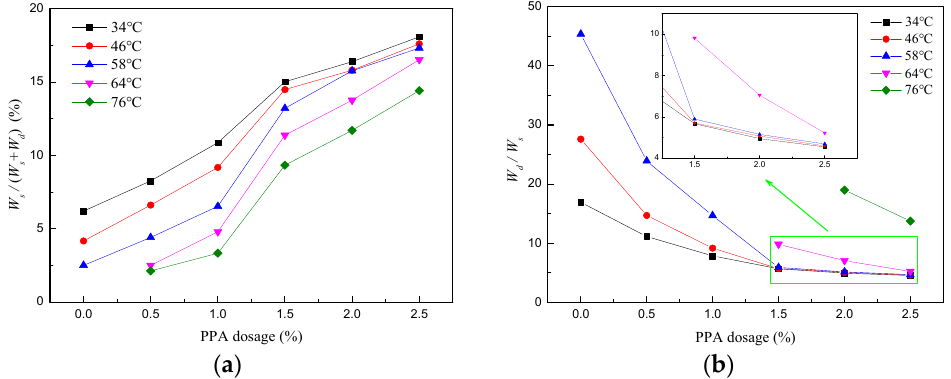
Figure 14. Energy ratio under different test conditions: ( a ) Percentage of stored energy at 0.1 kPa; ( b ) dissipation energy ratios at 3.2 kPa.